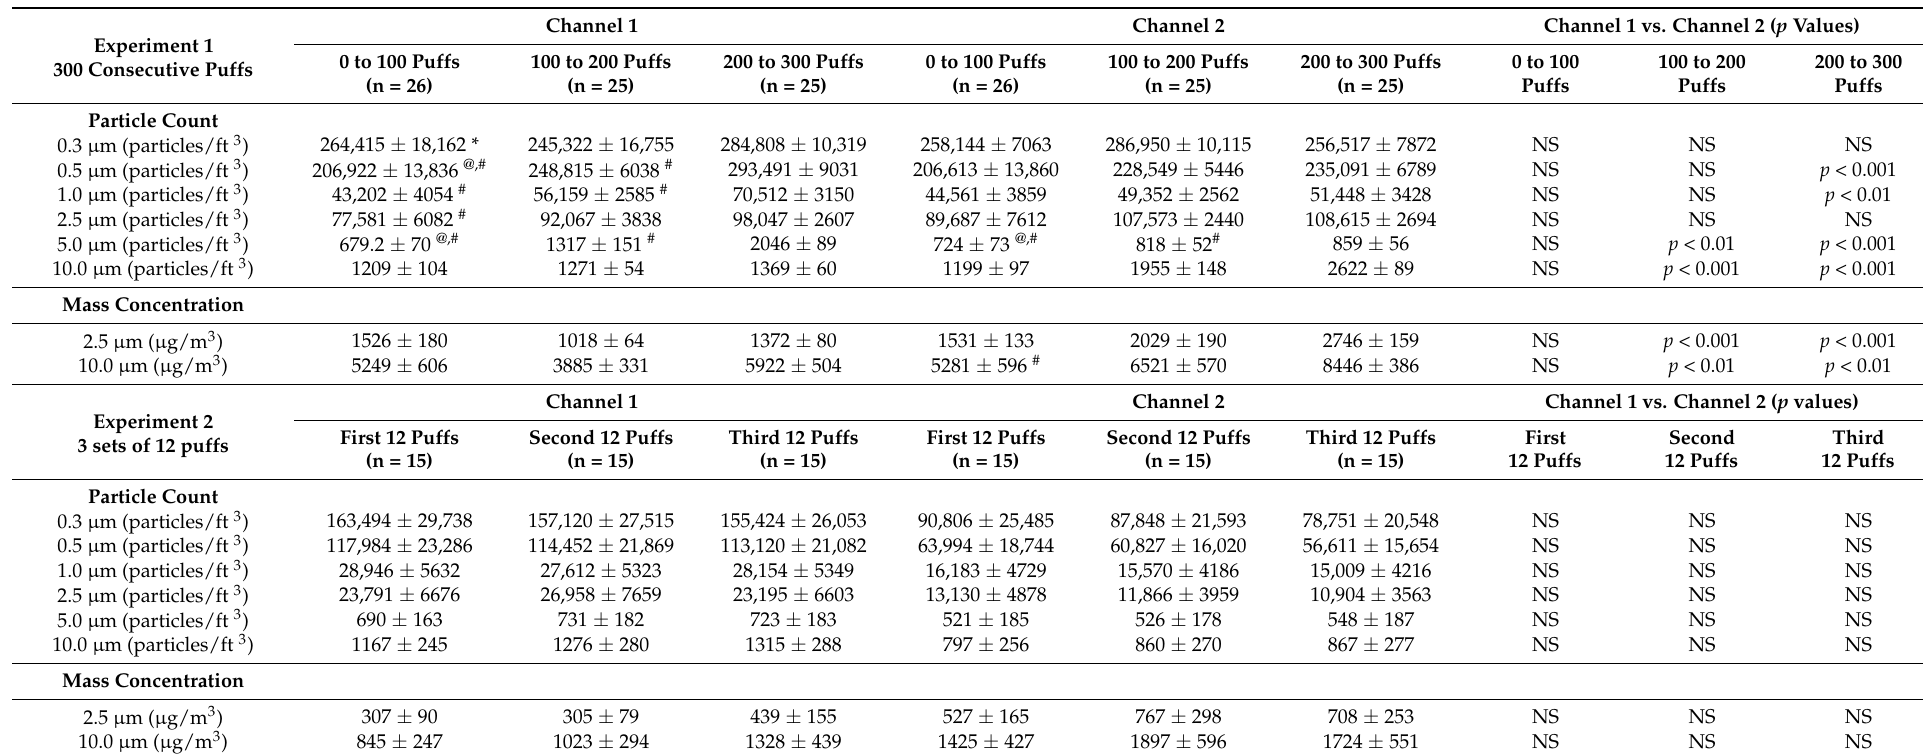
Table 4. Particle Counts and Mass